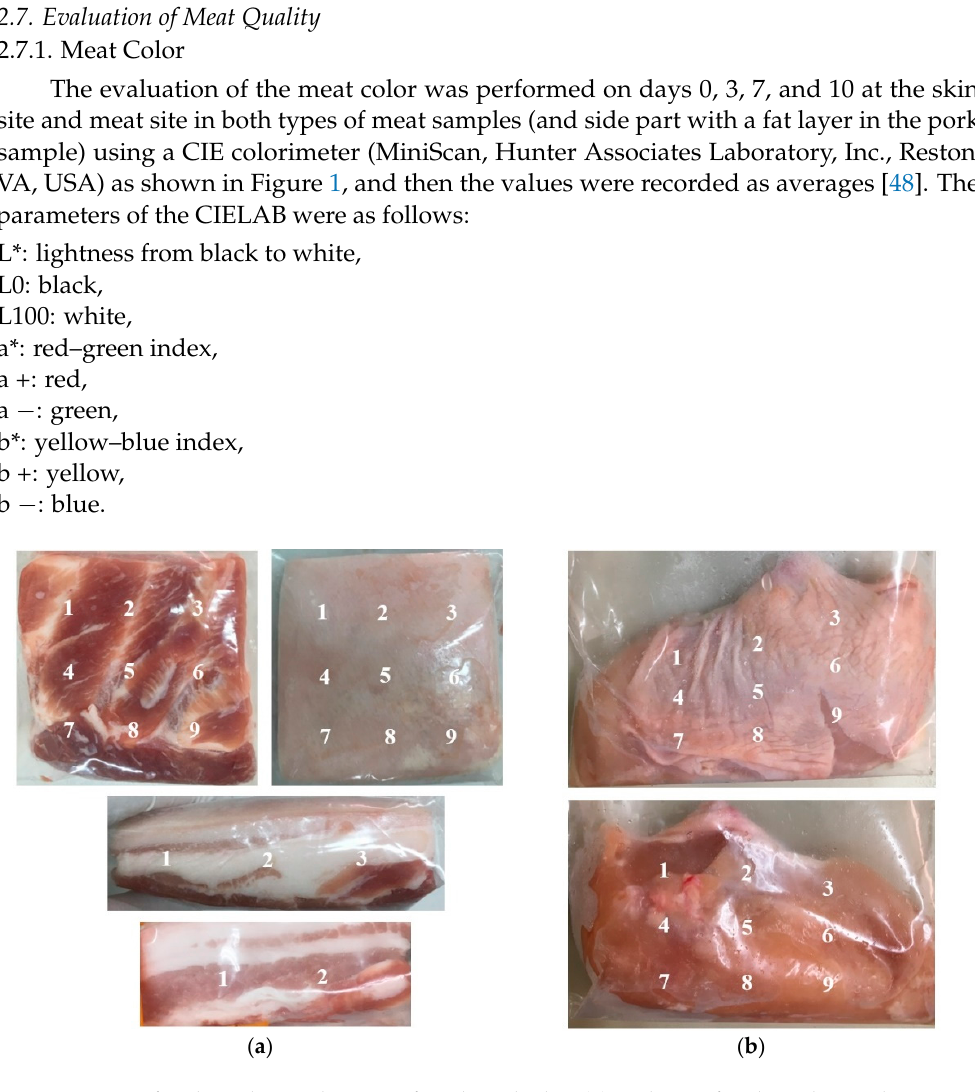
Figure 1. Sites for the color evaluation of pork with skin ( a ) and sites for the color evaluation of chicken meat with skin ( b ). chicken meat with skin ( b